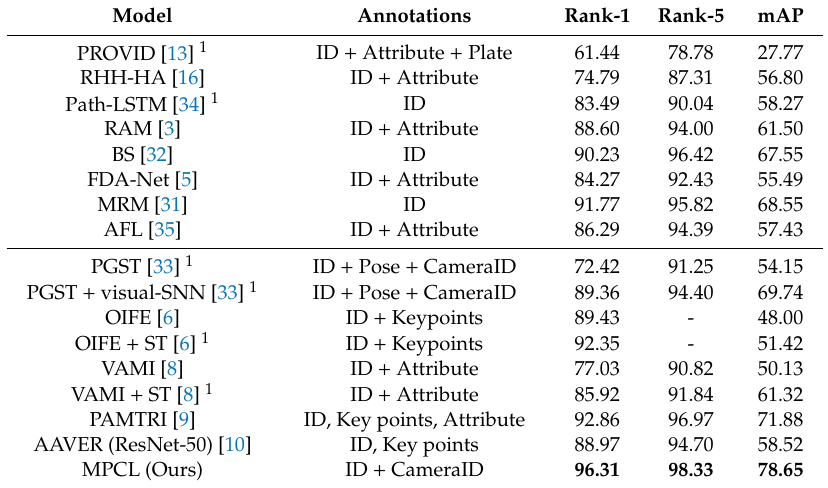
Table 1. Comparison of mAP (%) and match rate (CMC) at Top-k (%) on VeRi-776